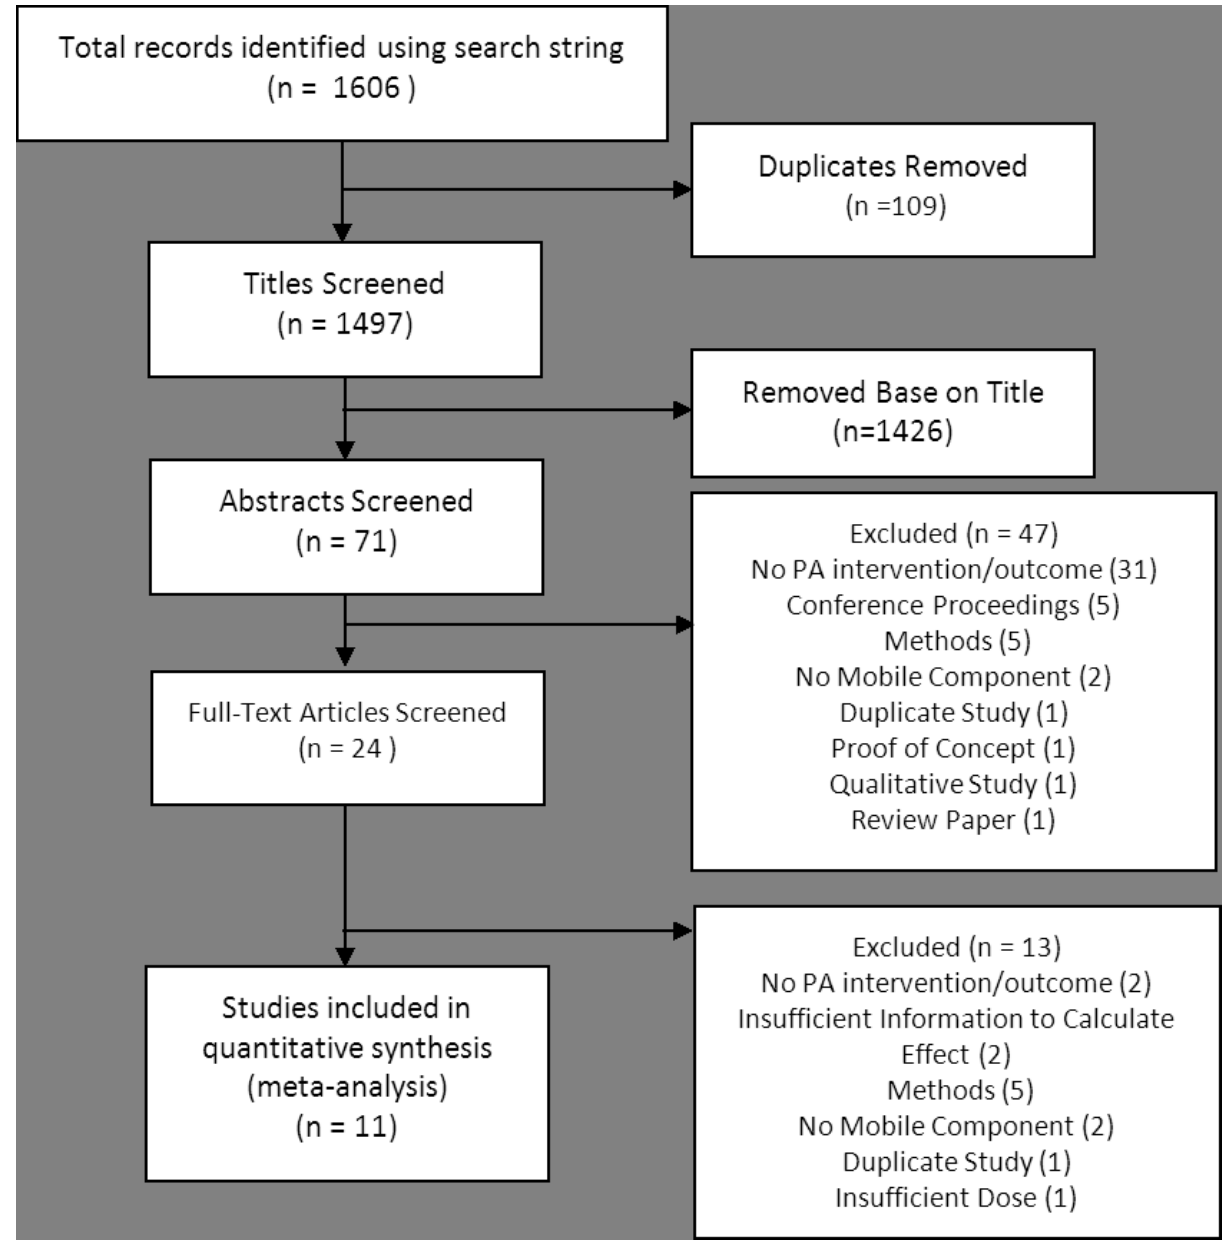
Figure 1. Flow diagram of study